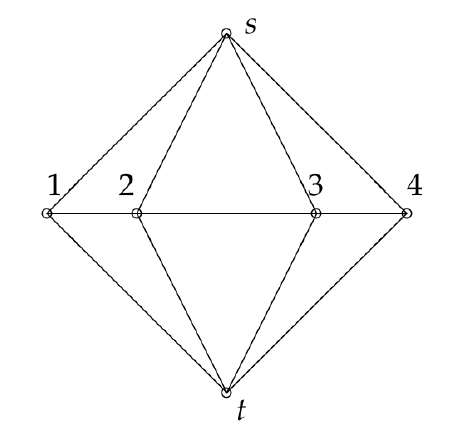
Figure 1. Graph DF 4